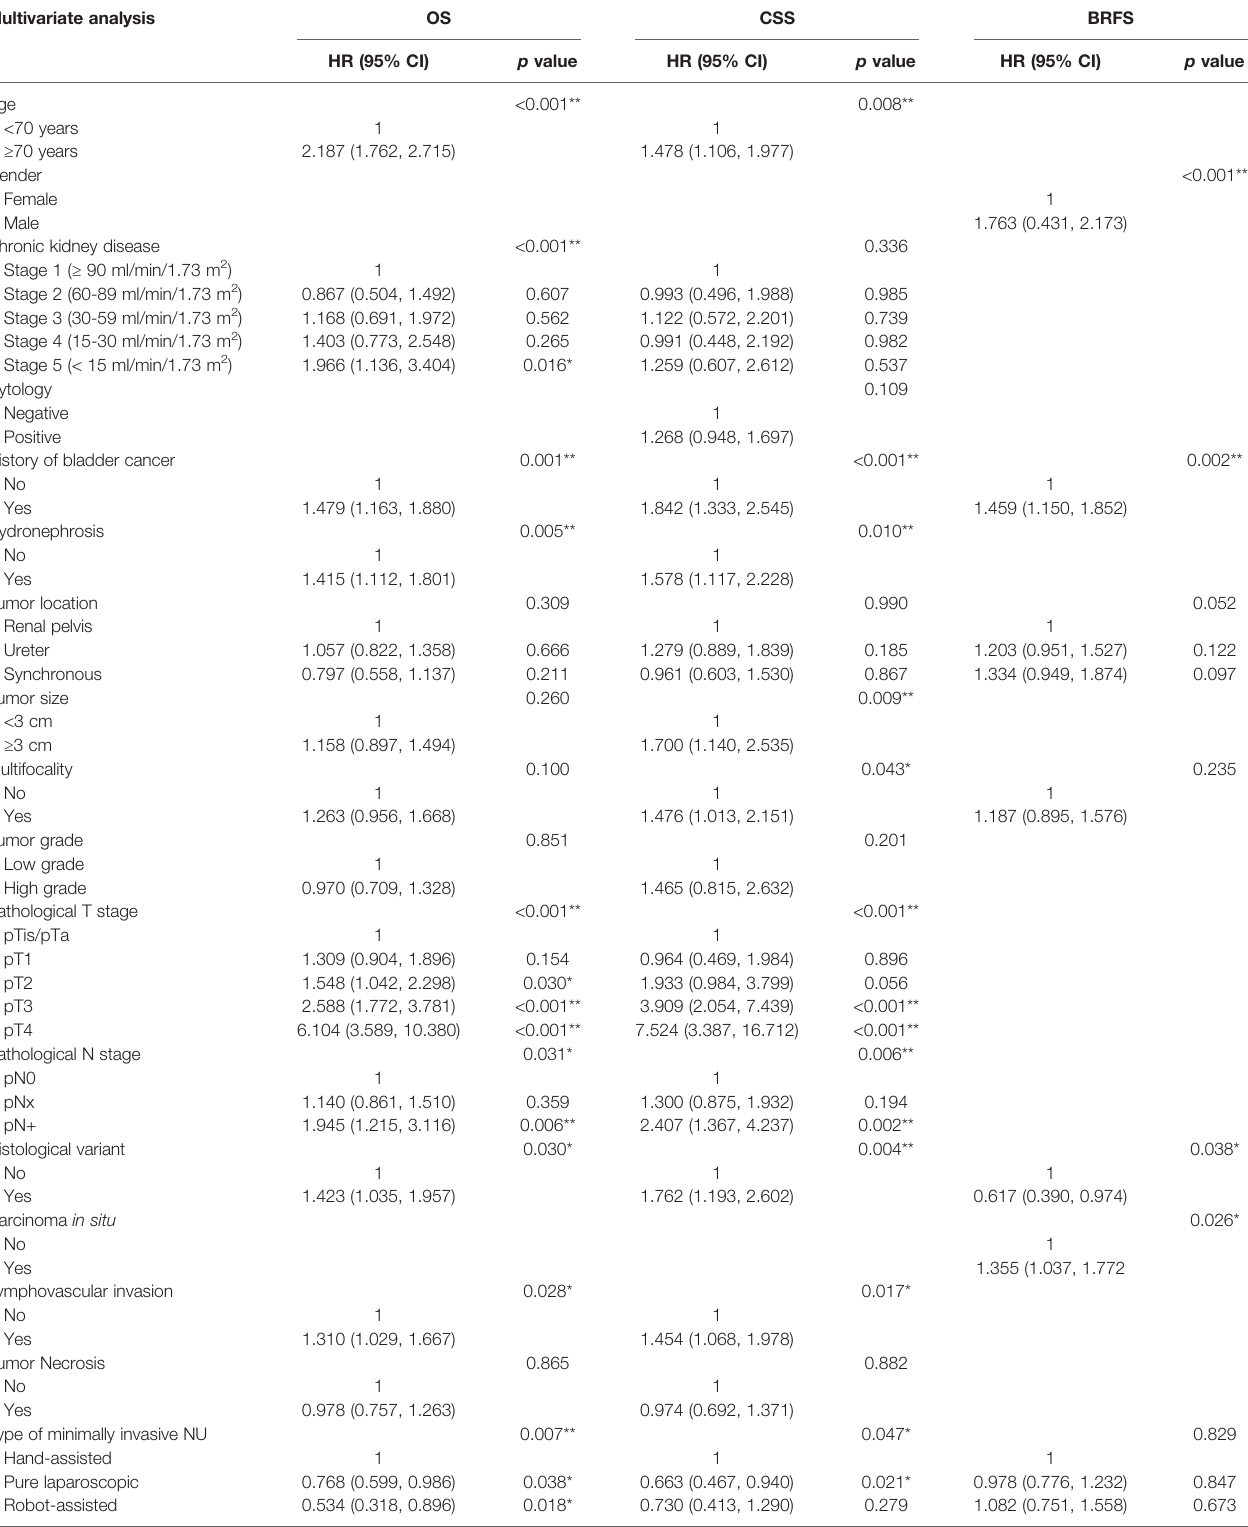
TABLE 3 | Comparative multivariate survival analysis of UTUC patients receiving minimally invasive NU. Multivariate